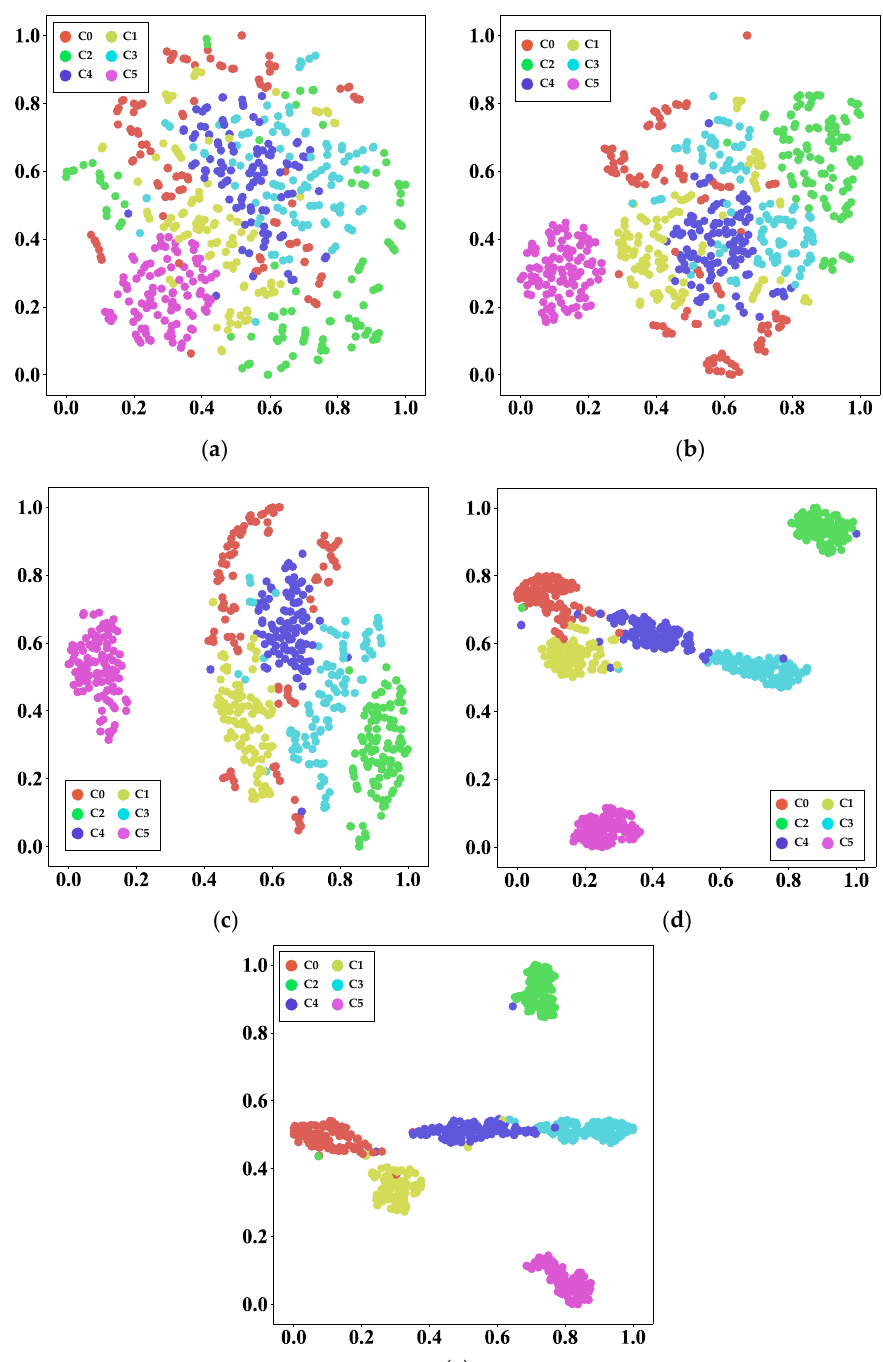
Figure 9. Feature visualization via t-distributed stochastic neighbor embedding (t-SNE) for raw data and all layers in task M → L: ( a ) raw data; ( b ) convolutional layer 1; ( c ) convolutional layer 2; ( d ) fully connected layer 1; ( e ) fully connected layer 2.